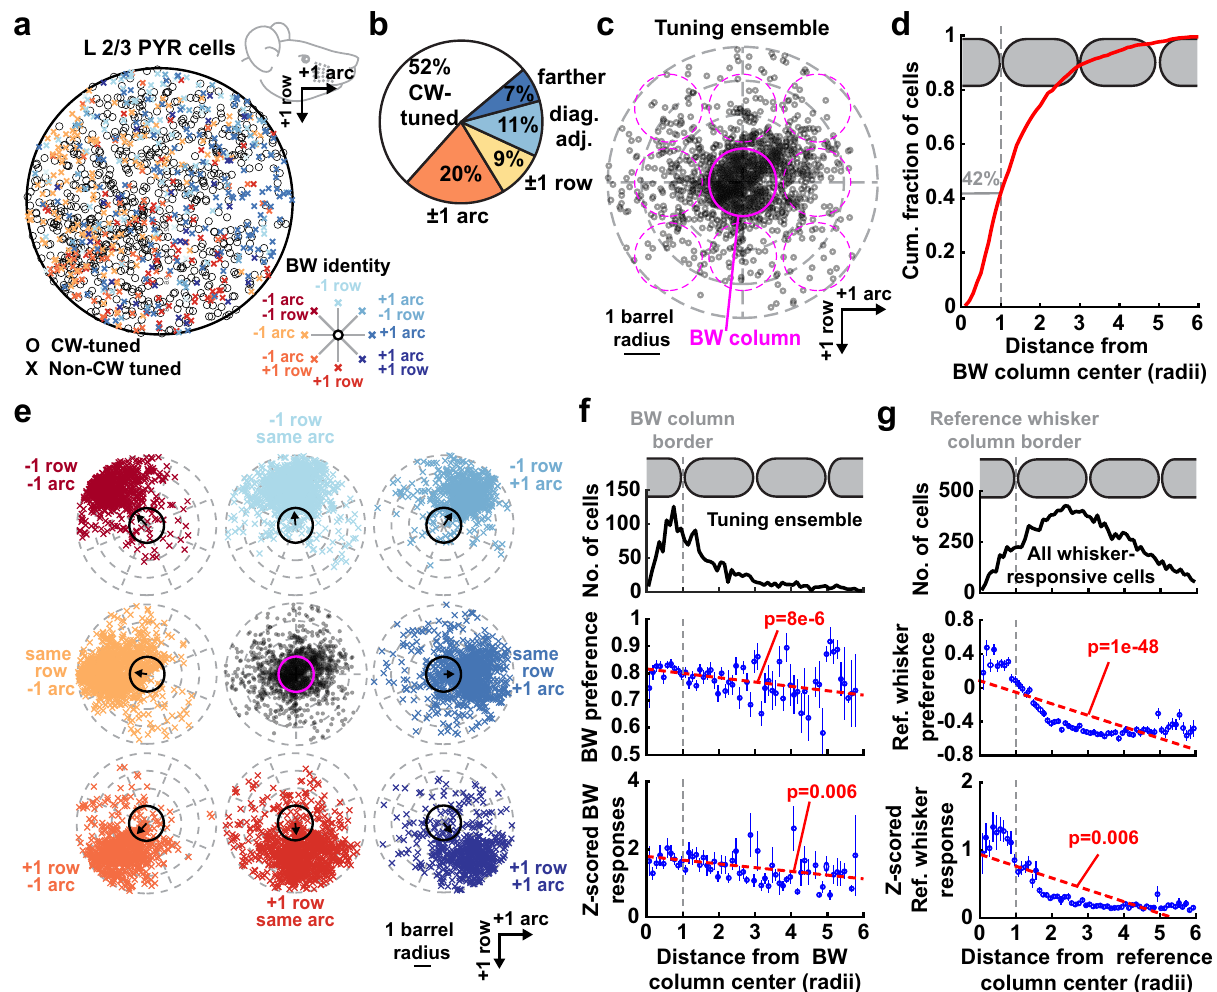
Fig. 2 | Whisker map topography for L2/3 PYR neurons in one-versus-all whisker-cuedmice.a Whiskertuning (BW identity)and location for allresponsive PYR neurons located within column boundaries ( n =1732). Circles, CW-tuned neurons. X ’ s, non-CW tuned neurons. Colors show BW identity relative to the col- umn where the cell resided. b Fraction of columnar cells tuned to different BWs. c Spatial distribution of the tuning ensemble, shown by plotting the location of eachPYRneuronrelativetoitsBWcolumn.Thisincludesbothcolumnarandseptal cells. Dashed magenta circles are nearby columns. d Distance from BW column center for cells in ( c ). e Locations of cells tuned to each of the 8 whiskers sur- rounding a central reference whisker. Locations are plotted relative to the refer- ence whisker column (black or magenta circle). Arrows show circular mean of cell locations. f BW tuning preference and mean BW response magnitude for all